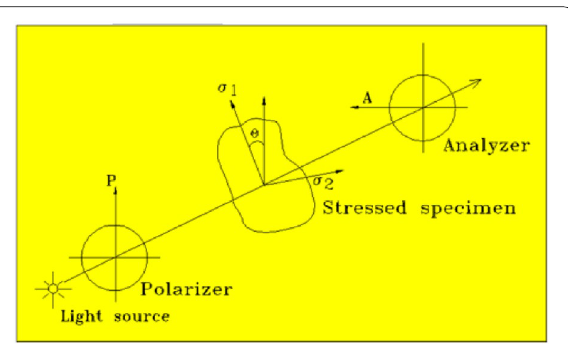
Figure 11 Plane polariscope of photo-elasticity apparatus